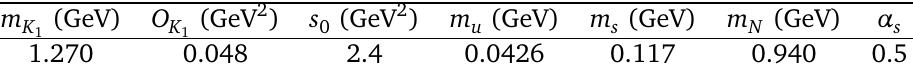
Table 1: Various parameters used in the present work [ 1 ] .